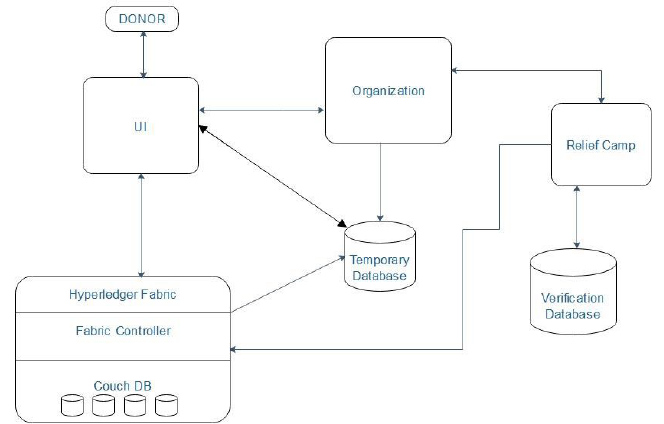
Fig. 1. Proposed System